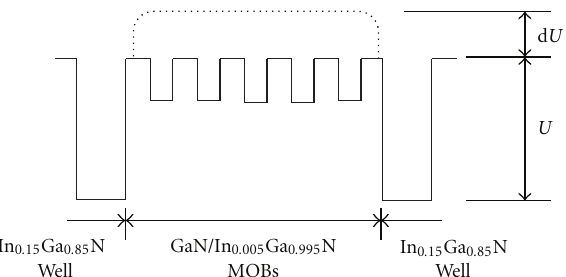
Figure 3: Schematic diagram showing potential energy profile of the MQB structure, where U and d U are the classical and enhanced barrier height,